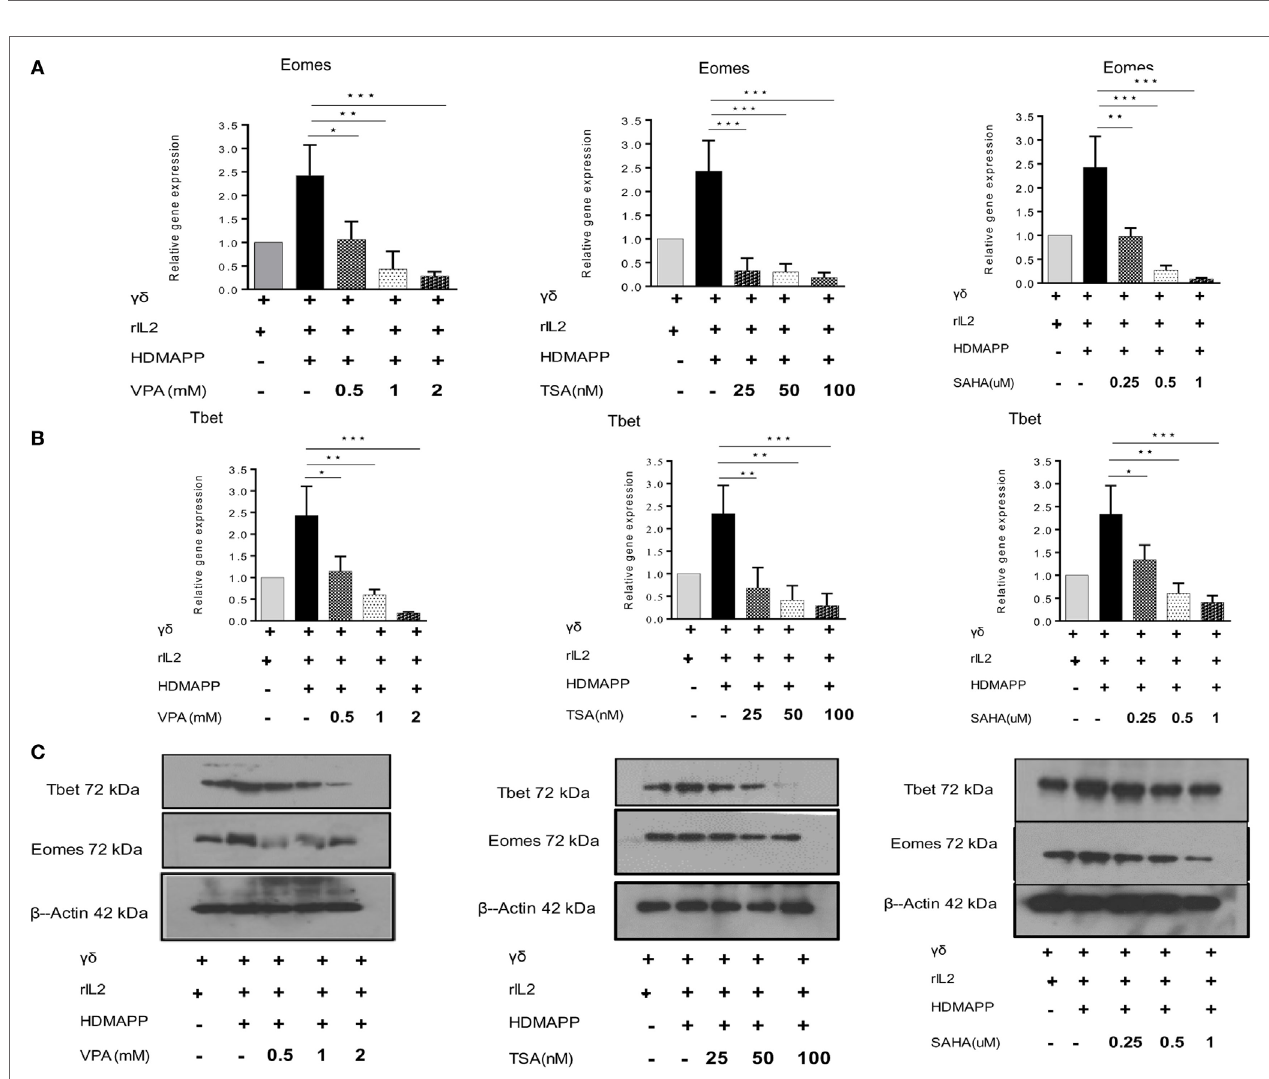
FigUre 3 | Histone deacetylases (HDAC) inhibitors affect the activation markers on γδ T cells. (a) The expression of early activation marker (CD69) on unstimulated γδ T cells and HDMAPP and rIL-2 stimulated γδ T cells with or without HDAC inhibitor treatment was analyzed by multi-color flow cytometry. Values on right side indicate the median fluorescence intensity (MFI) of CD69, while the values inside the histogram represent the percent CD69-positive γδ T cells. The histograms shown are representative of three independent experiments. (B) The cumulative MFI of CD69 expression on γδ T cells is represented as bar graphs. Data shown are representative of three independent experiments where * p < 0.05, ** p < 0.005, *** p < 0.0005. (c) The effect of HDAC inhibitors on expression of late activation marker CD25 was assessed by flow cytometry. Unstimulated γδ T cells and HDMAPP stimulated γδ T cells with or without HDAC inhibitors at different concentrations, after 72 h were stained with the flurophore-tagged antibody and acquired on FACS Aria. Values on right side indicate the MFI of CD25, while the values inside the histogram represent the percent CD25-positive γδ T cells. The histograms depicted are representative of three independent experiments. (D) The results shown are cumulative MFI of CD25 expression on γδ T cells. HDAC inhibition decreases expression of CD25. Data shown are representative of three independent experiments where * p < 0.05, ** p < 0.005, *** p < 0.0005.